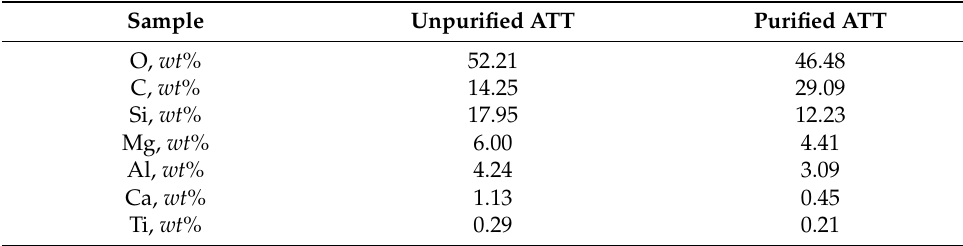
Figure 2. Energy dispersion spectroscopy of ATT: ( a ) unpurified ATT, ( b ) purified ATT. Table 2. Elemental compositions of unpurified and purified of ATT.